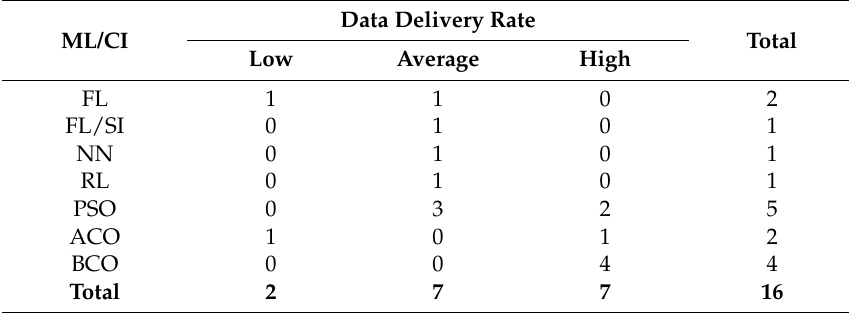
Table 3. Comparison of CI’s approaches according to the data delivery